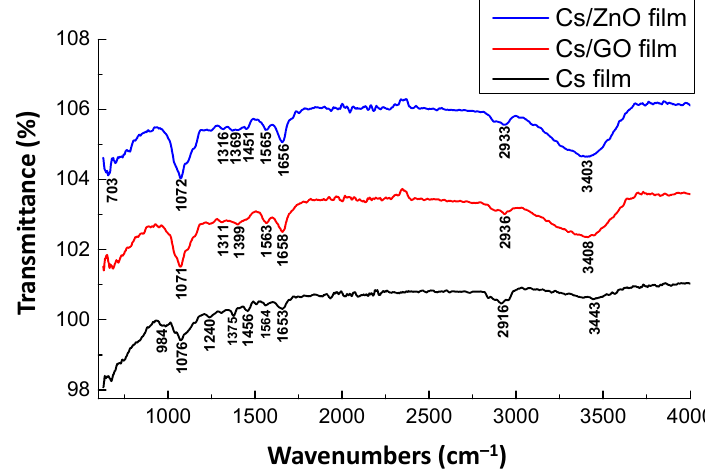
Figure 3. FTIR spectra of CS, CS / GO, and CS / ZnO composite thin film cross-linked by GA.